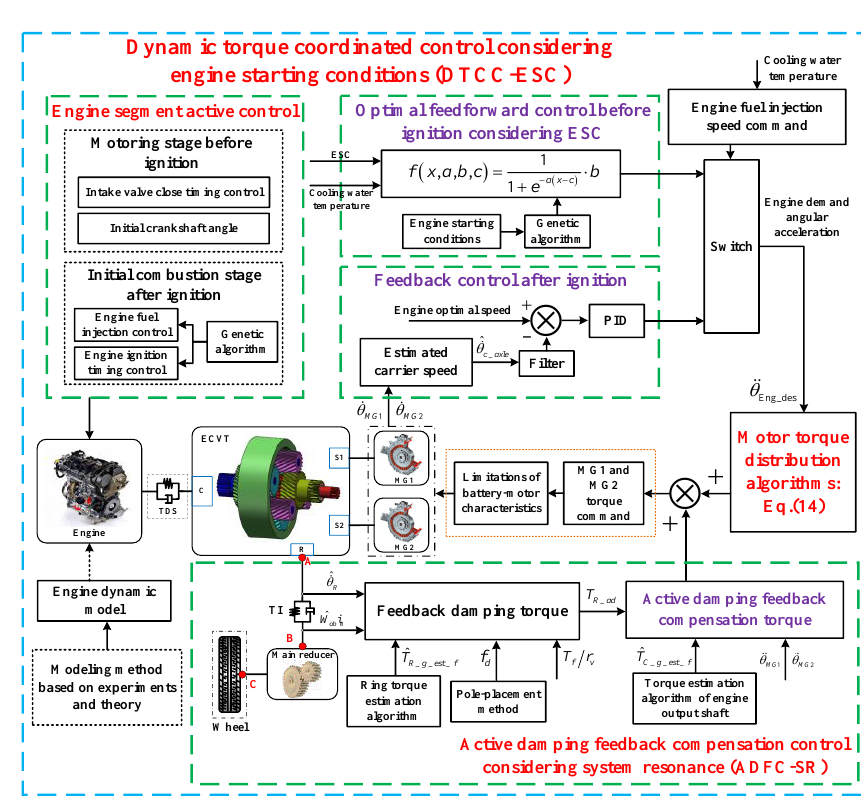
Figure 8. Block diagram of the dynamic torque coordinated control